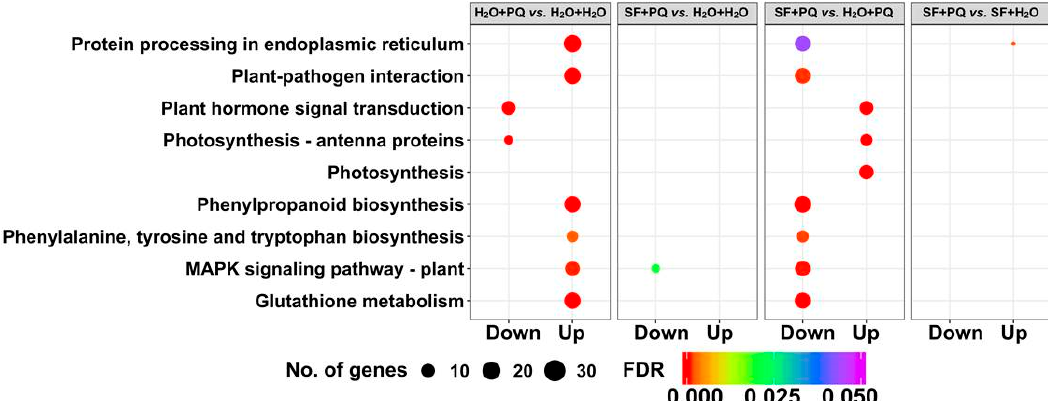
Figure 3. Comparison of the top five enriched KEGG (Kyoto Encyclopedia of Genes and Genomes) pathways. The top five (i.e., most significant, enriched) KEGG pathways from all pairwise combinations are illustrated as a bubble plot. The size and color of the circle denotes the number of differentially expressed genes and FDR adjusted p -value, respectively. Unprimed and unstressed (H 2 O + H 2 O), PQ-stressed (H 2 O + PQ), SF-primed but unstressed (SF + H 2 O), and SF-primed and stressed (SF + PQ).